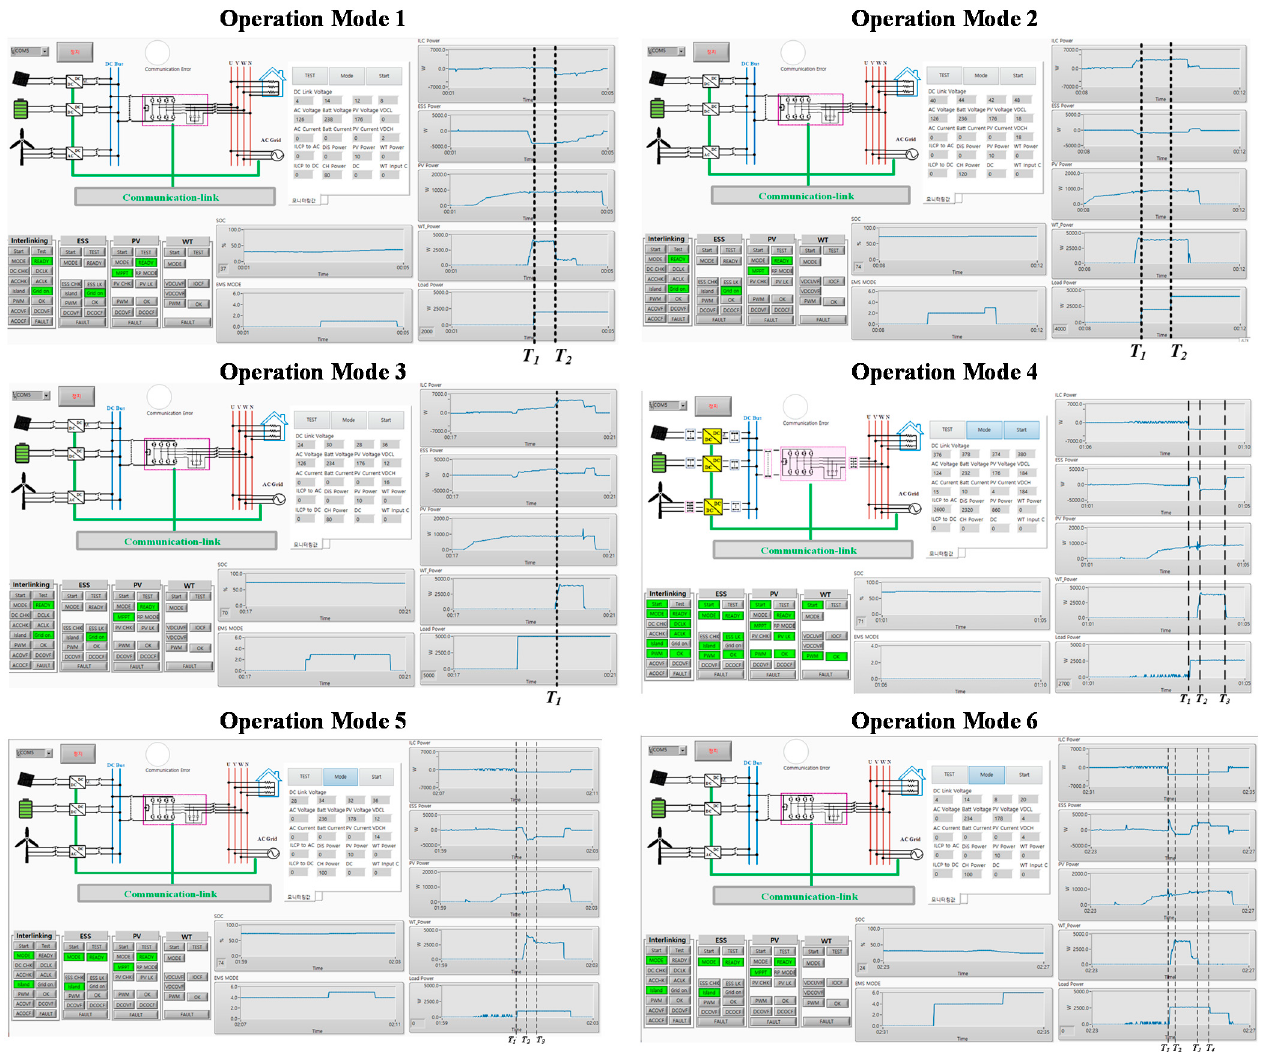
Figure 26. Screen configuration of EMS monitoring system according to each operation mode.